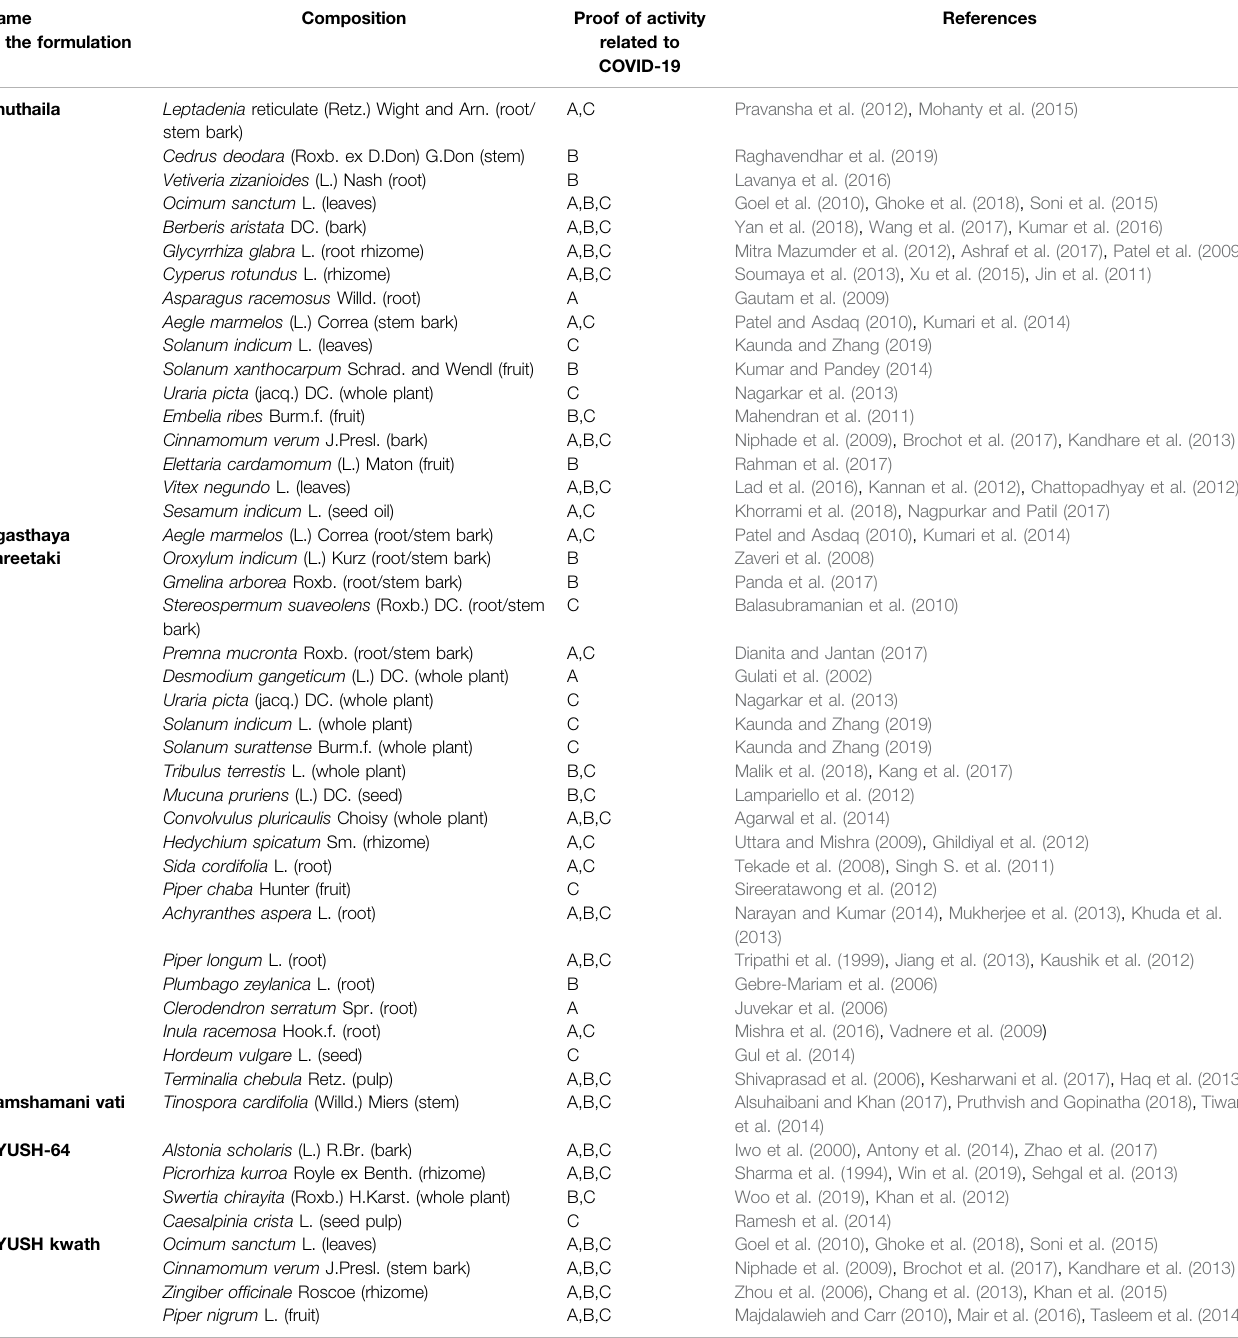
TABLE 2 | AYUSH recommended prophylactic approach through Ayurvedic formulations. Ref: AYUSH Ministry of Health Corona Advisory-D.O. No. S. 16030/18/2019- NAM; dated: 06th March, 2020. Ref: AYUSH Ministry of Health Corona Advisory -F.No. Z 25.23/09/2018 – 2020-DCC (AYUSH); dated: 24th April, 2020. Name of the